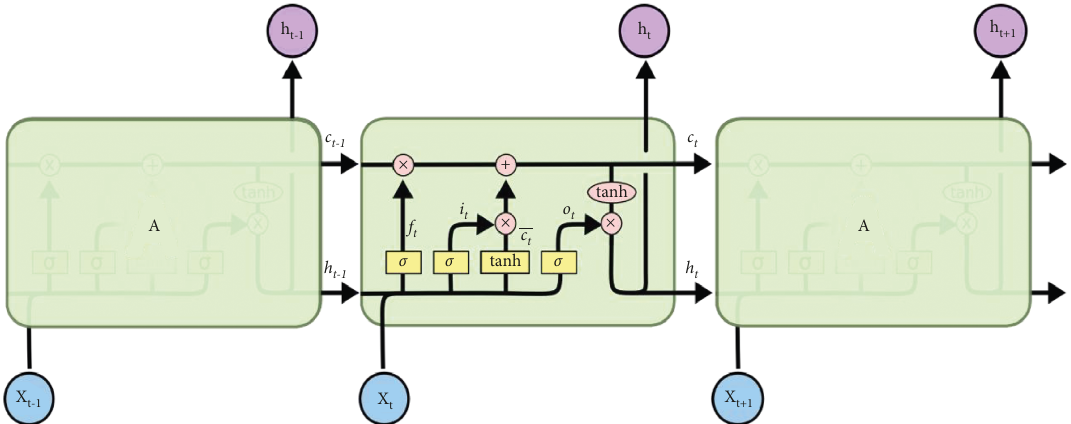
Figure 2: Schematic diagram of the LSTM model. Table 1: Input and output of the neural network. Network